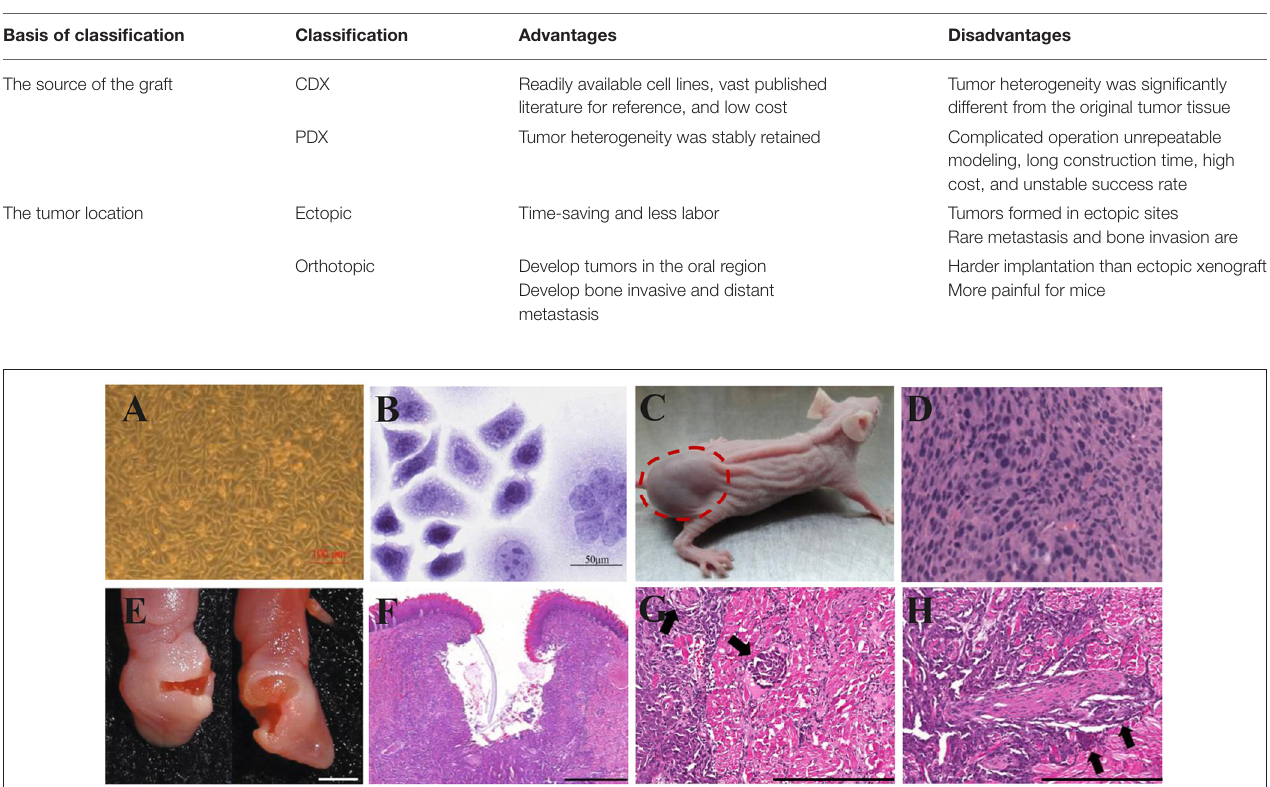
FIGURE 4 | Xenograft OSCC mouse models. (A–D) An ectopic mouse model of OSCC. (A) OSCC-BD cells overlapped and lost contact inhibition. (B) HE staining showed that OSCC-BD cells had malignant characters. (C) The nude mice were subcutaneously injected with OSCC-BD cells. Tumor formation was observed, and neoplasms were about 1.0 ± 0.2cm in size. (D) HE staining showed the neoplasm was typical squamous cell carcinoma. Scale bars, 100 µ m (A) and 50 µ m (B) . Reproduced and modified with permission ( 110). Copyright © 2015, Springer Nature . (E–H) An orthotopic mouse model injected into the lateral border of the tongue of non-obese diabetes–severe combined immune deficiency (NOD-SCID) mice via HSC-3 cells. The HSC-3 bearing tumors have (E,F) ulcers, (G) neural, and (H) vascular invasion (arrows). Scale bars, 0.2cm (E) , 400 µ m (F) , and 200 µ m (G,H) . Reproduced and modified with permission (111). Copyright © 2018, Springer Nature